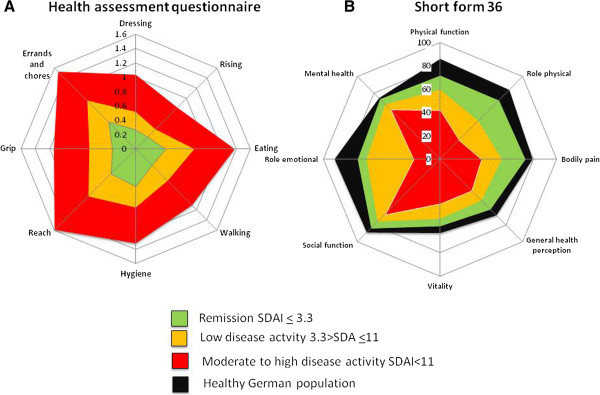
Analyses of variance: Significant differences of different domains of Health Assessment Questionnaire (HAQ, A) and SF-36 physical component Score (PCS, score of 0 indicates poorest status, and 100 indicates best status; B) among levels of disease activity determined by SDAI (remission REM < 3.3; 3.31 < low disease activity (LDA) < 11; 11.01 < moderate to high disease activity (MDA/HDA)).